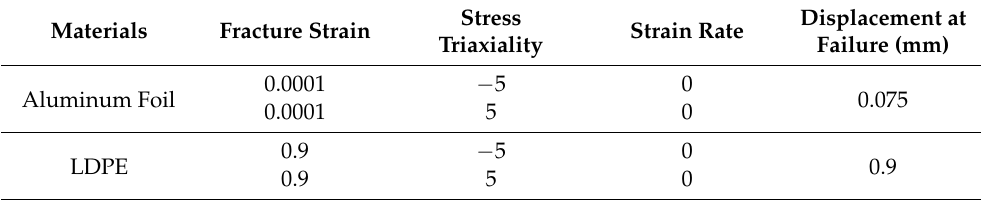
Table 5. The ductile damage initiation damage evolution values for aluminum foil and